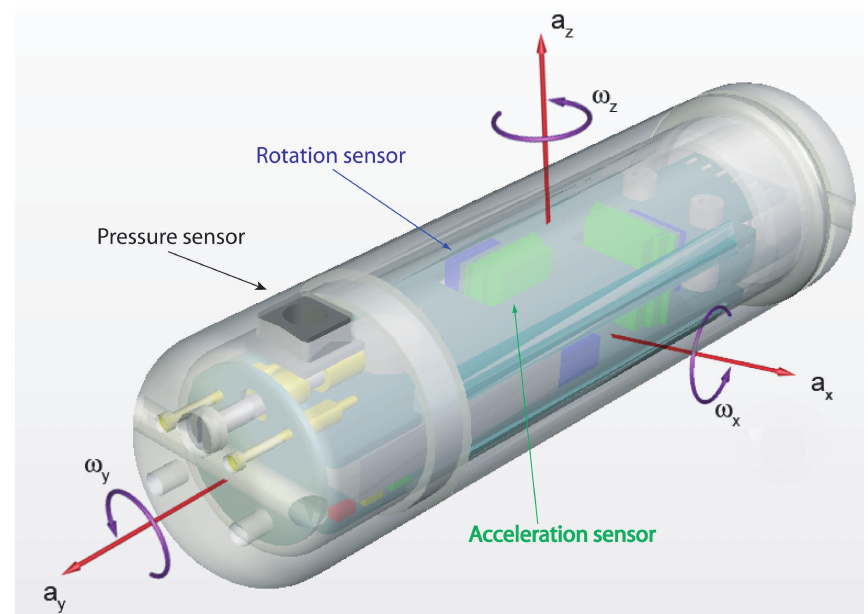
Figure 4 . The Sensor Fish device showing the location of the measurement axes for the three rate gyros (that measure angular velocity, ω ), three linear accelerometers (that measure the acceleration, a ), and pressure